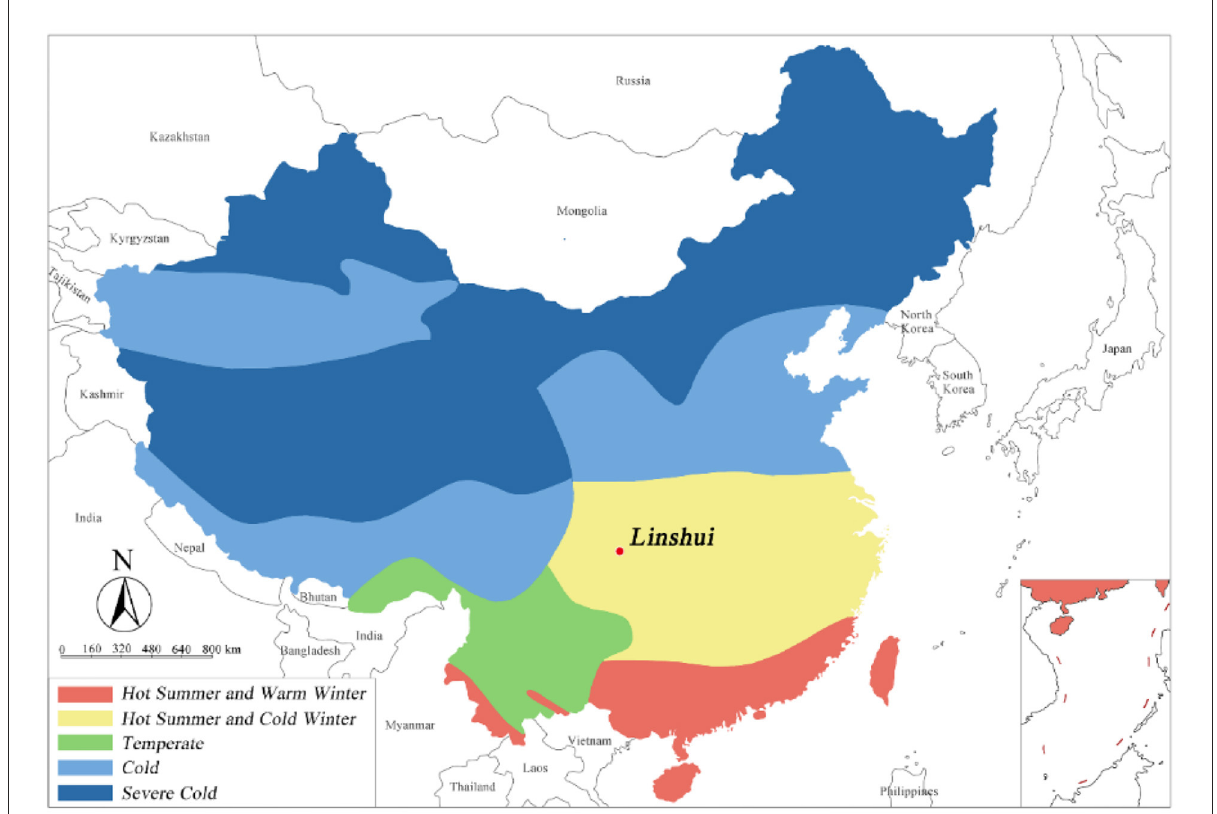
FIGURE1 Climate region for building thermal design of China. Adapted from the Code for Thermal Design of Civil Buildings, GB 50176–2016.